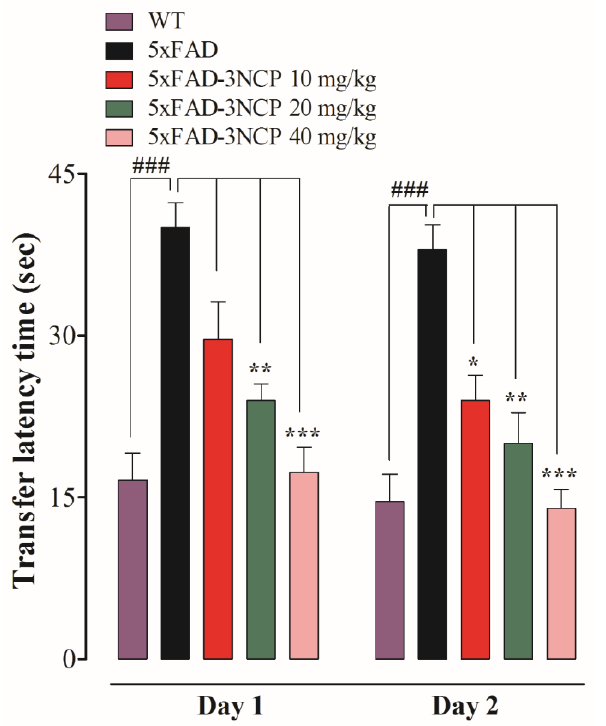
Figure 4. Effect of the 3NCP on the memory of 5xFAD mice in the EPM test. Data were analyzed with one ‐ way ANOVA followed by the Dunnett post hoc test. * p < 0.05, ** p < 0.01, *** p < 0.001 compared to the 5xFAD ‐ group and ### p < 0.001 compared to the WT group.